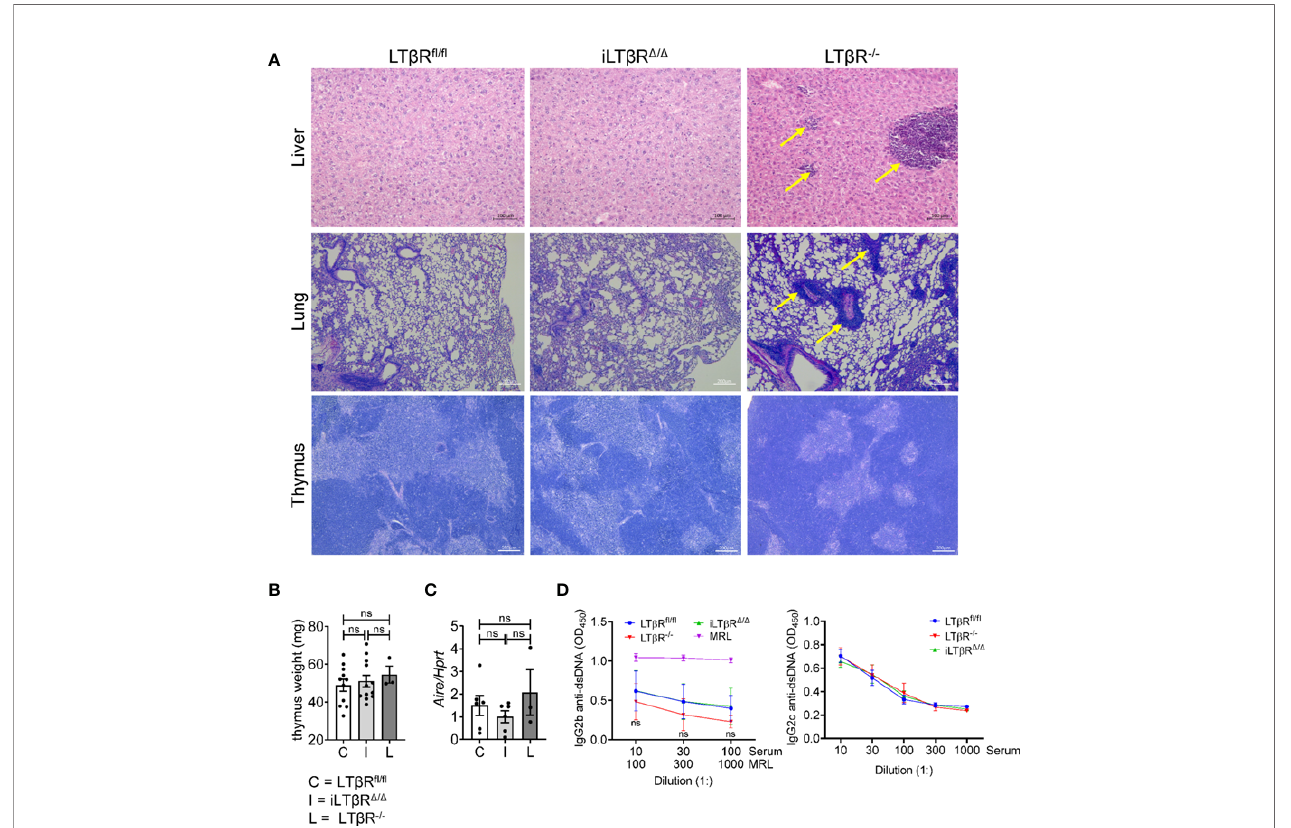
FIGURE 3 | iLT b R D / D mice do not develop autoimmunity. (A) Representative H&E images of liver (scale bars 100 m m), lung (scale bars 200 m m), and thymus (scale bars 200 m m) from iLT b R D / D mice at one (liver and lung) or two (thymus) months post TAM treatment. Oil treated LT b R fl / fl (C) and untreated LT b R -/- (L) mice were used as controls. Arrows indicate lymphoid in fi ltrates in LT b R -/- mice. N=5 for all groups. (B) Thymus weight. n=3-12. (C) Expression of Aire mRNA in thymus determined by qPCR (n=3-6 per group). (D) Analysis of anti-dsDNA antibodies by ELISA in mice 2-4 months after TAM treatment (n=20 for WT, n=14 for iLT b R D / D , n=9 for LT b R -/- ). Data shown are means ± SEM. Bars show the mean, symbols represent individual mice. Data was derived from 1-2 experiments for all panels. Signi fi cance was determined using one-way ANOVA with Tukey ’ s correction. Not signi fi cant (ns,